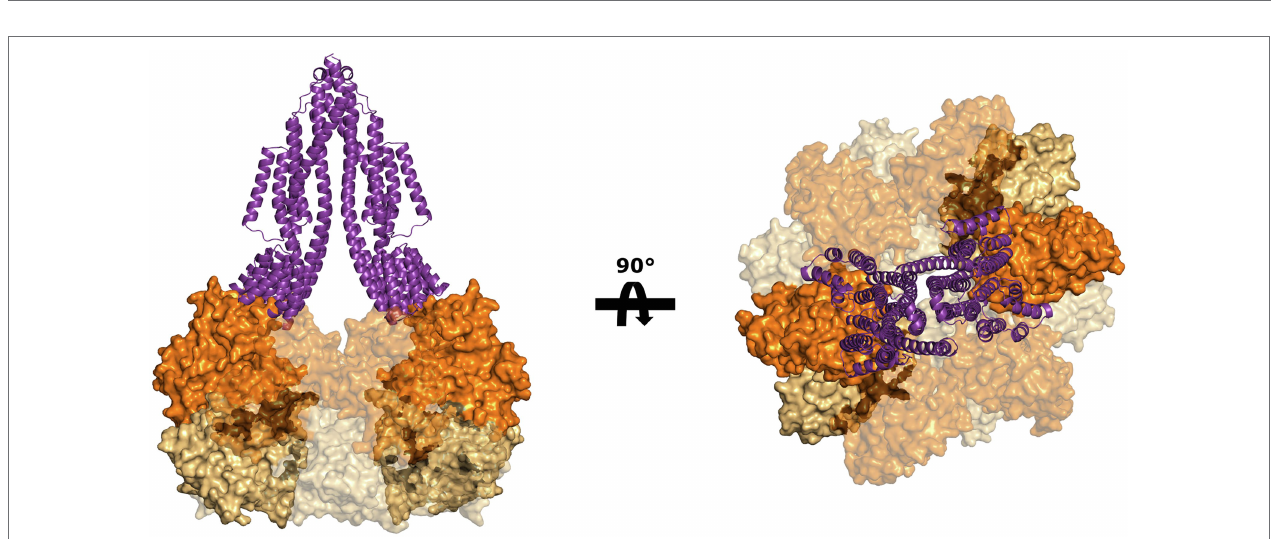
FIGURE 5 | Putative interaction between ArlJ and ArlI. The charge complementarity between the N-terminus of ArlI (PDB-4IHQ) and the cytosolic domain of the AlphaFold prediction of the ArlJ dimer from S. acidocaldarius suggests how the two proteins may interact. The model is shown in side view (left) and as seen from the pseudo- periplasm (right). In the model (highlighted), which would have important consequences for the mechanism of